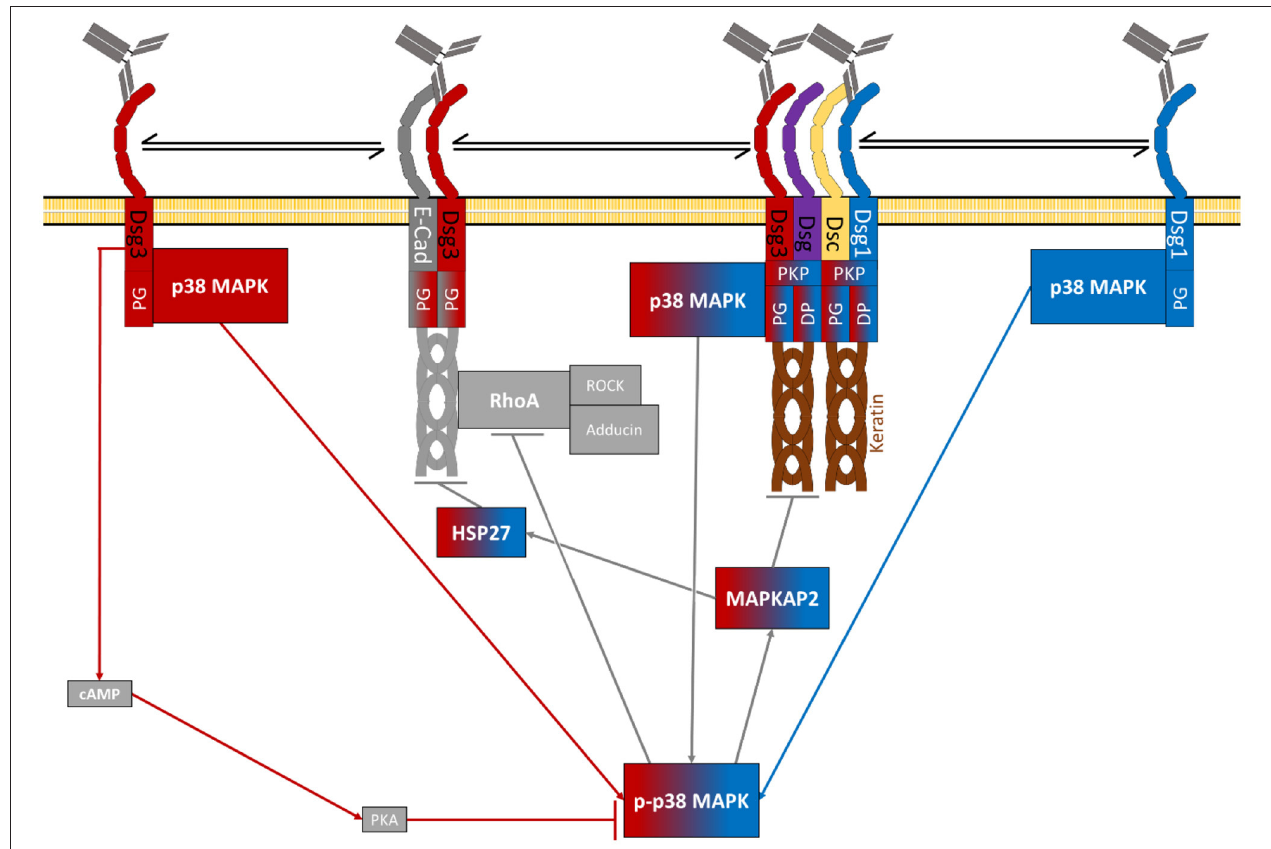
FIGURE 2 | Schematic depiction of p38MAPK-dependent signalling in pemphigus (grey RhoA and cAMP steps represent potential rescue